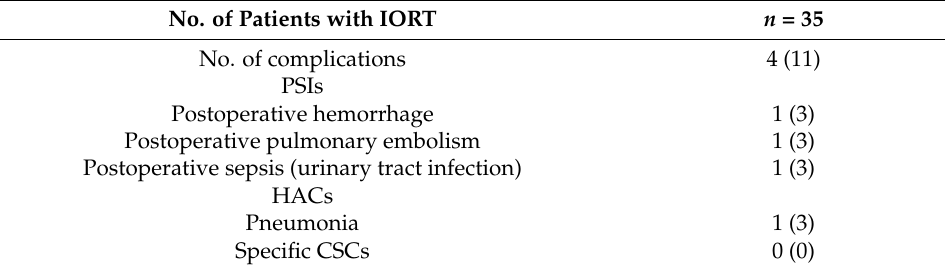
Table 2. Overview of perioperative complications of patients with IORT. No. of Patients with IORT